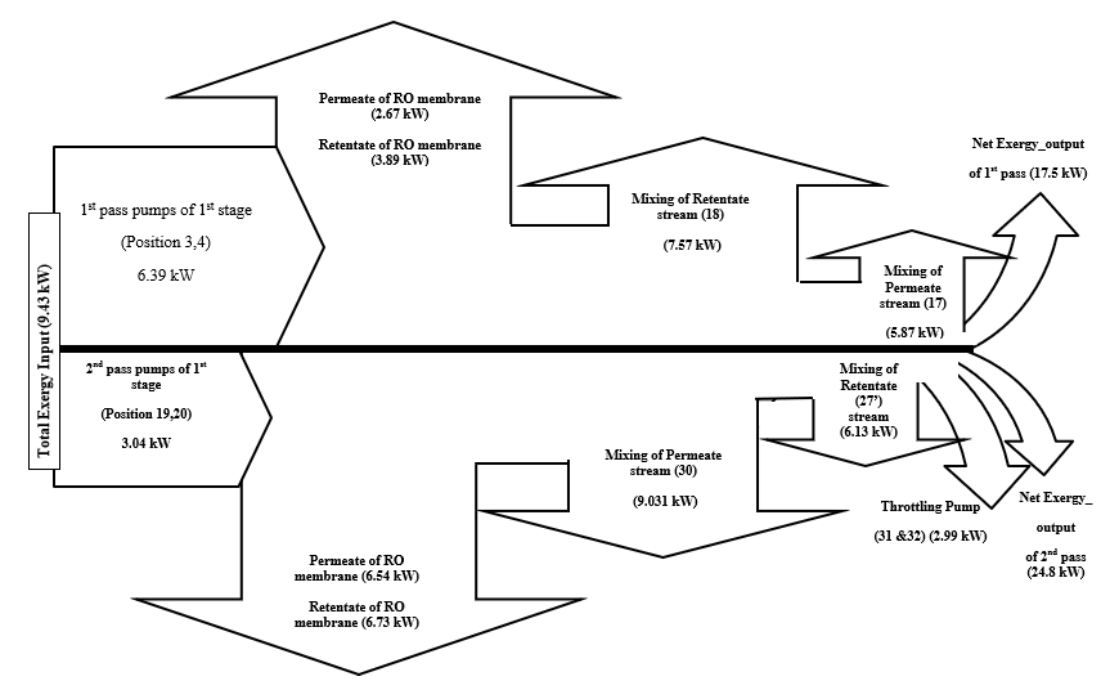
Figure 2. Rate of exergy change flow chart of the RO system of the APC. Note: Positive values of rate of exergy change specify input exergy, while negative values specify destroyed rate of exergy